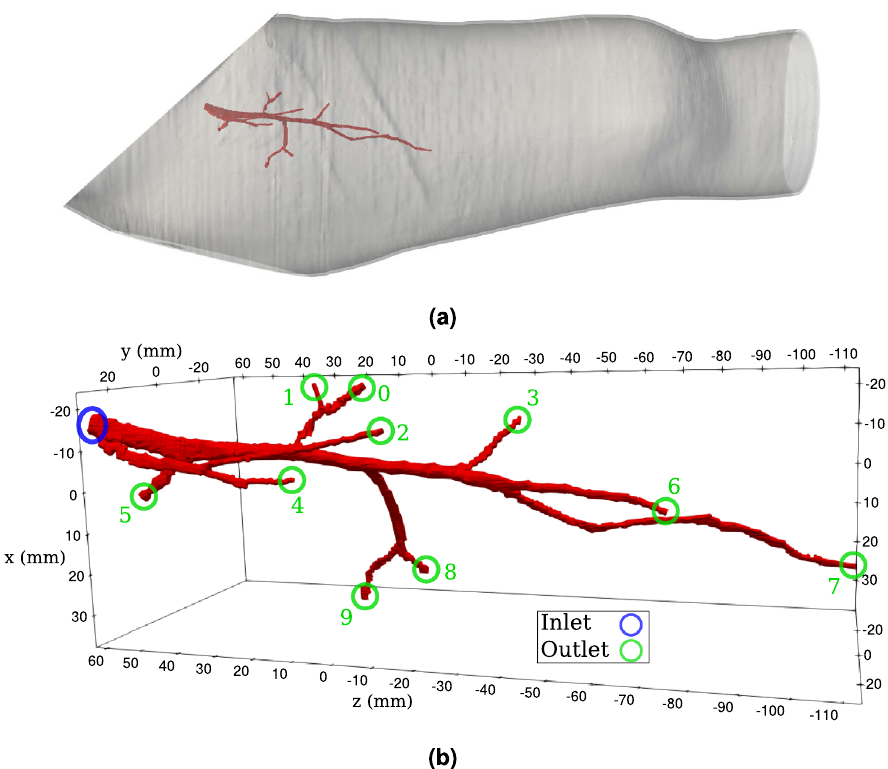
Figure 2. The profunda femoris model used in this study is constructed from the profunda femoris artery on the right thigh of a human subject, as shown in (a) . The location of the inlet and the outlets are indicated in (b) with the index of the outlets